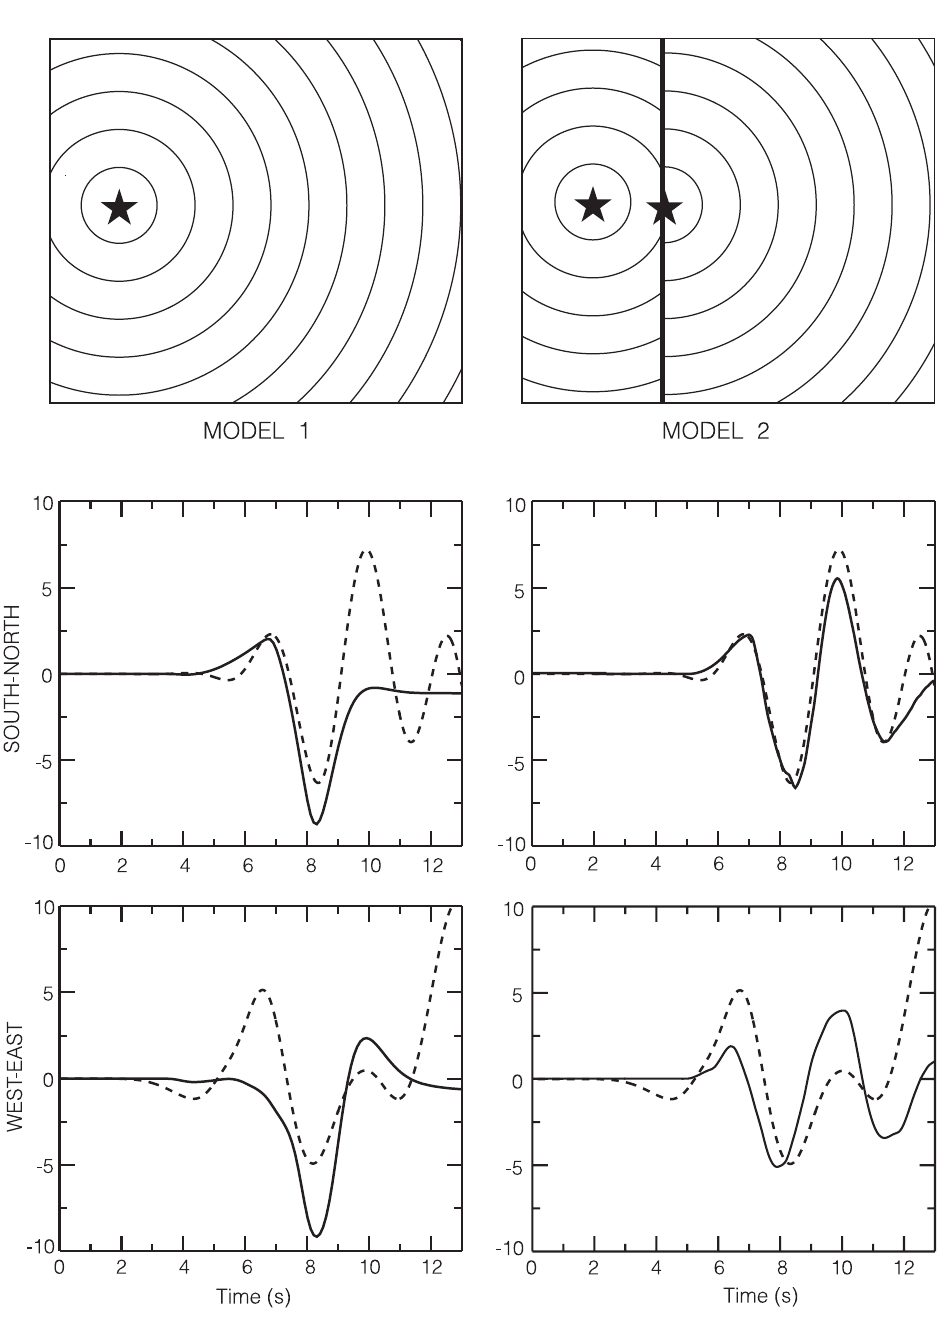
Fig. 5. Rupture models from the inversion of the accelerogramm. Continuous line: observed signal; dashed line: synthetic